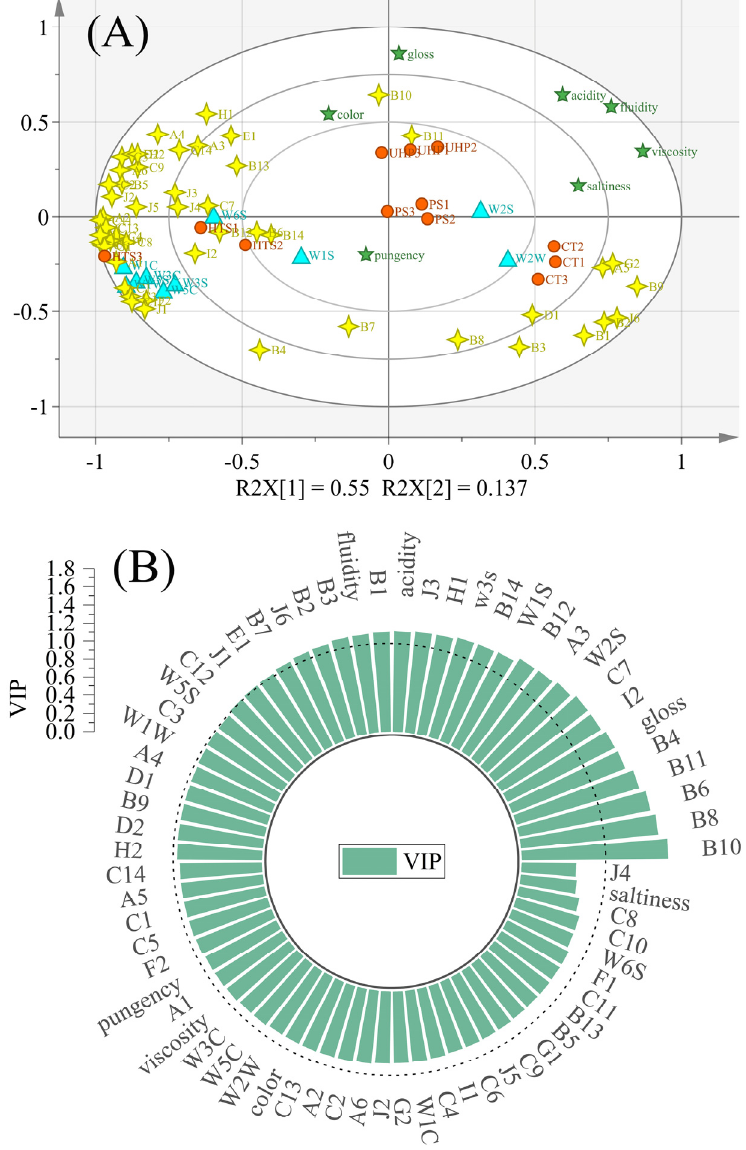
Figure 6. ( A ) PLS − DA analysis of each index (Orange circle: sample; Green five − pointed star: sensory evaluation index; Blue triangle: electronic nose sensor; Golden four − pointed star: some volatile compounds); ( B ) The VIP values of indicators calculated from the PLS regression model.